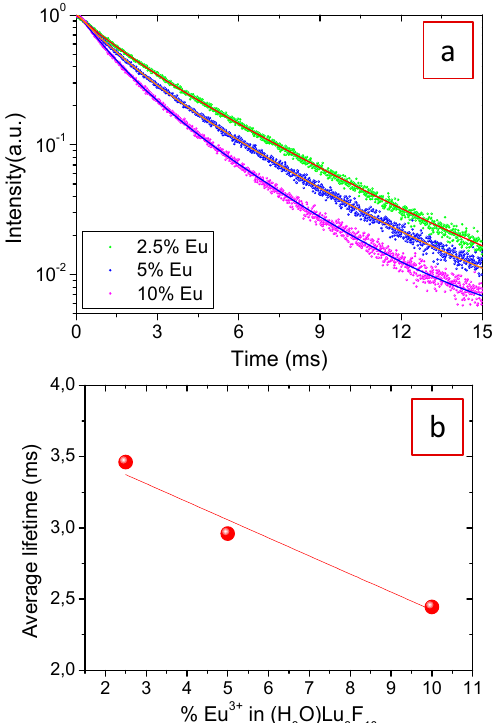
Figure 7. ( a ) Experimental (dots) and fitted (solid lines) temporal decays for the 5 D 0 → 7 F 2 transition (611 nm) of the Eu 3+ :(H 3 O)Lu 3 F 10 nanoparticles with different Eu 3+ contents; ( b ) average lifetime values calculated from such decays.